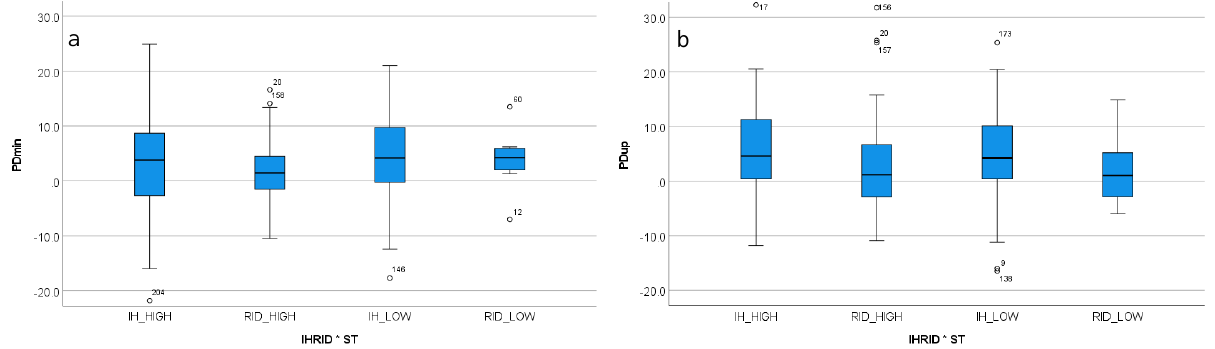
Figure 3. Box plots for significant two-way interactions for ( a ) PDmin and ( b ) PDup. PDmin and PDup are the only two variables to be significantly affected by the two-way interaction of in-hand versus ridden exercise with stride time. For both sacral asymmetry parameters there is a tendency for the ridden exercise to show lower asymmetry values (closer to zero). All movement asymmetry parameters are shown in mm. PDmin: minimum difference for vertical sacral movement; PDup: upward movement amplitude difference for vertical sacral movement; IH: in-hand exercise rein; RID: ridden exercise; HIGH: higher than average stride time; LOW: lower than average stride time.